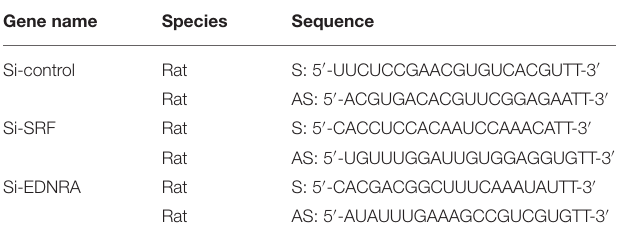
TABLE 2 | The sequences of